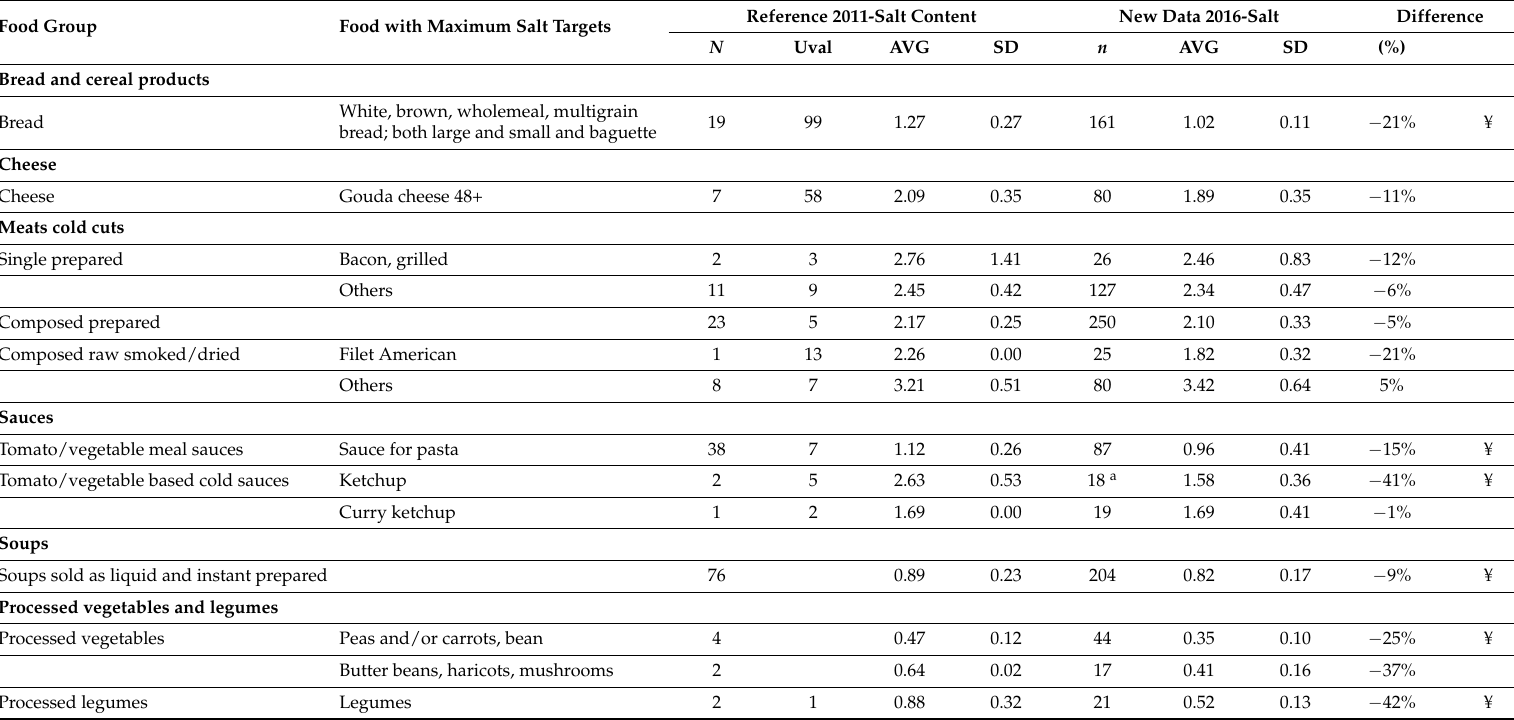
Table 3. Salt contents of foods with salt reduction targets (g/100 g) in 2016 compared to